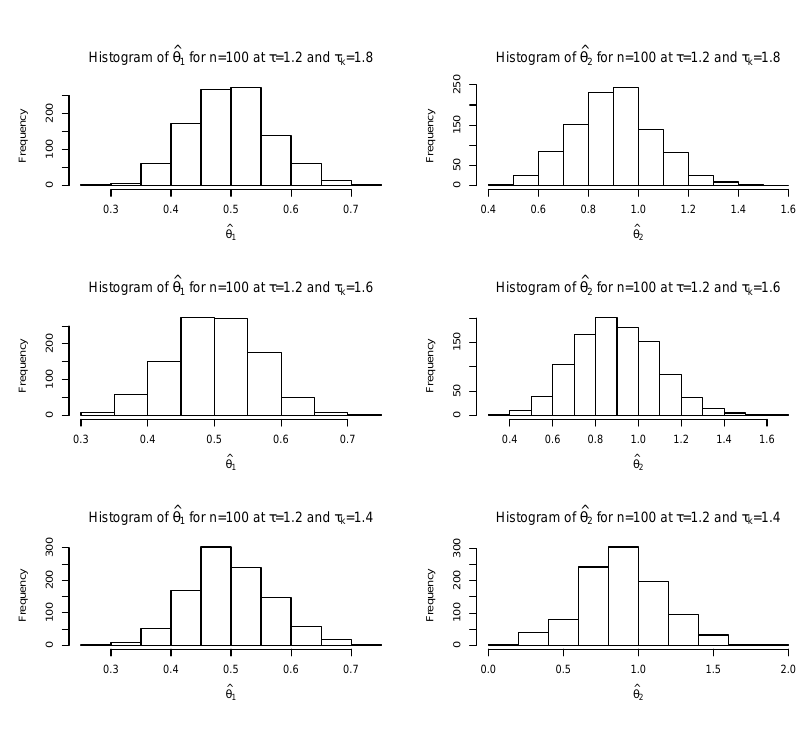
b θ b θ 1 and 2 for 1000